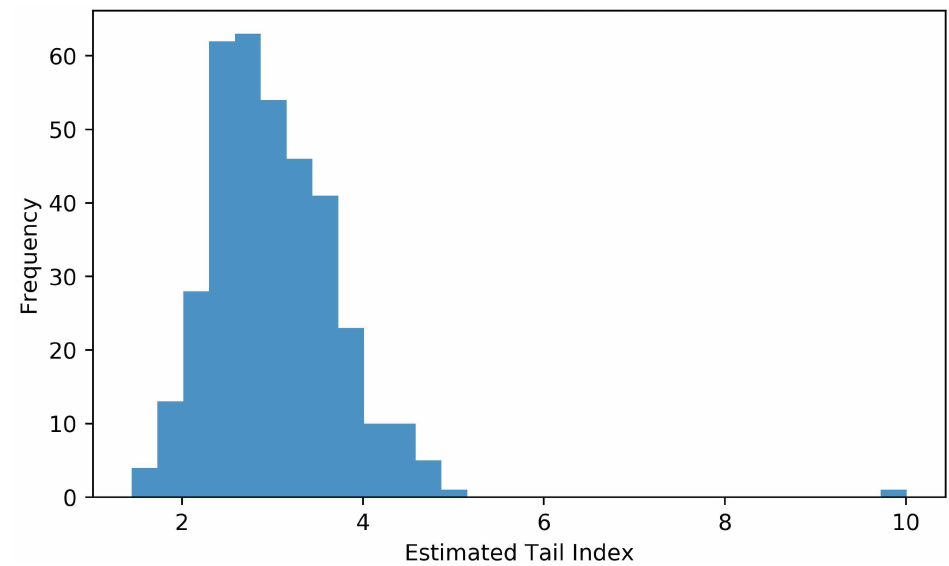
Figure 9. Distribution of tail indices of all 361 stocks. Table 4. Number of stocks across